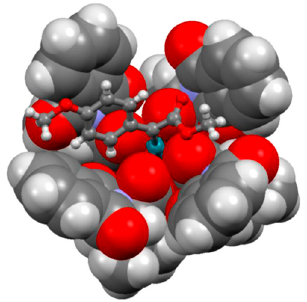
Figure 3. Space ‐ filling model of the Rh 2 ( S ‐ PTTL) 4 = C(MeOC 6 H 4 )CO 2 Me unit (top view). (Reprinted Figure 3. Space-filling model of the Rh 2 ( S -PTTL) 4 = C(MeOC 6 H 4 )CO 2 Me unit (top view).